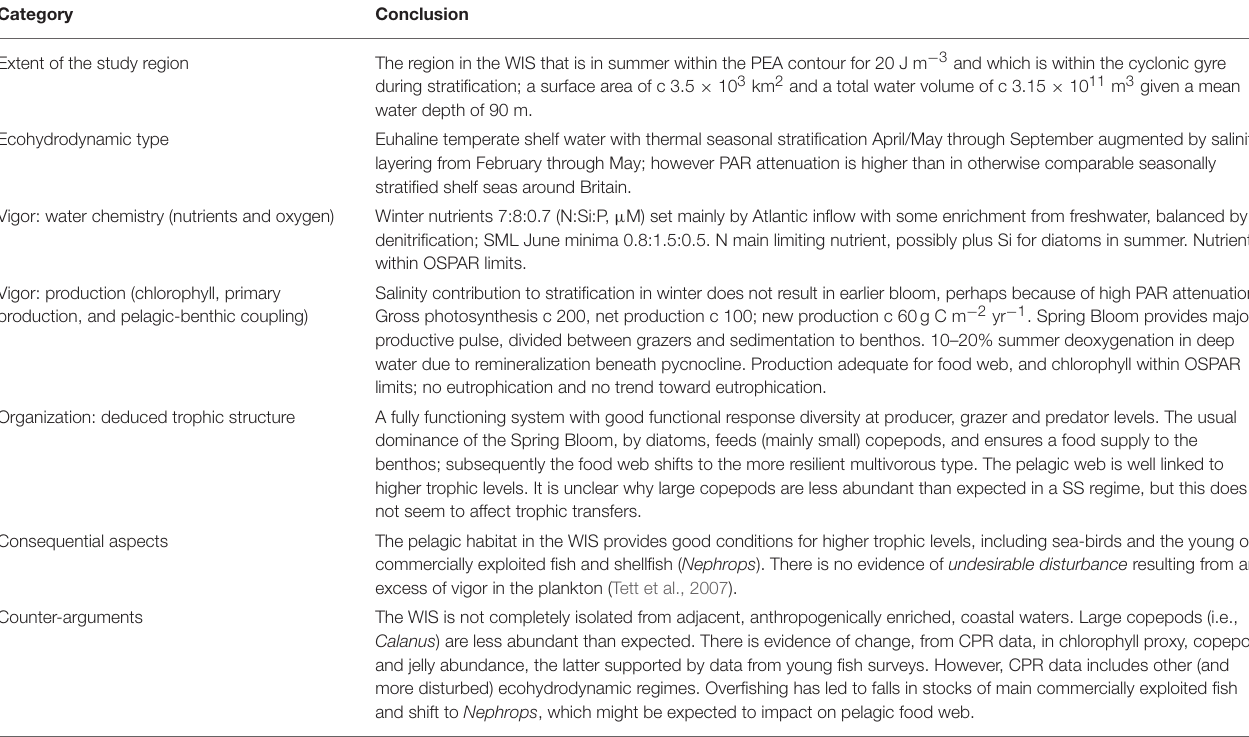
TABLE 9 | Summary of conclusions relating to status at the study site WIS. Category Conclusion Extent of the study